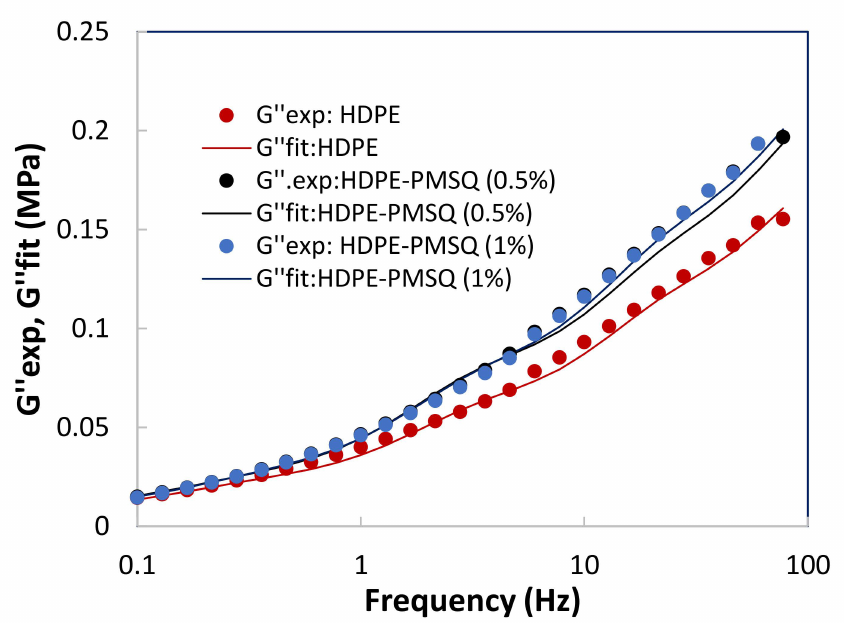
Figure 5. Results of the optimization with the experimental loss moduli G” as a function of the PMSQ nanoparticles